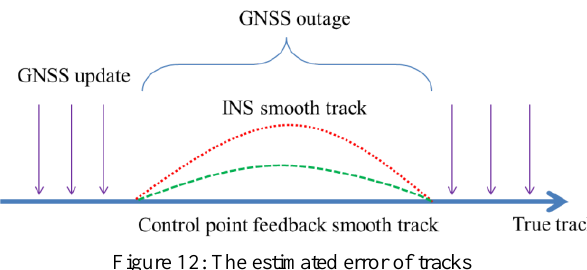
Figure 12: The estimated error of tracks